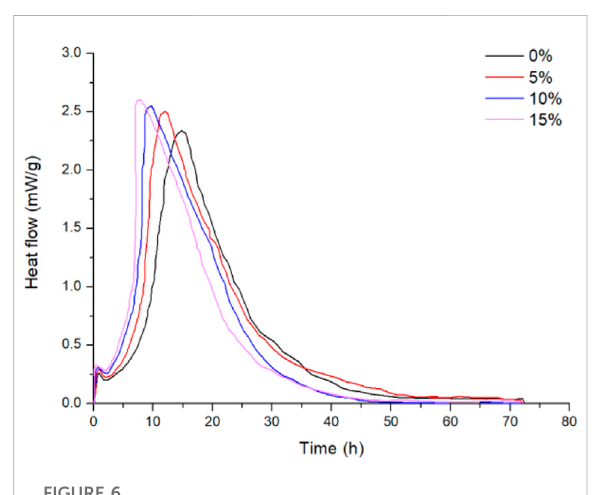
FIGURE 6 Effect of CSA on the heat fl ow of oil well cement